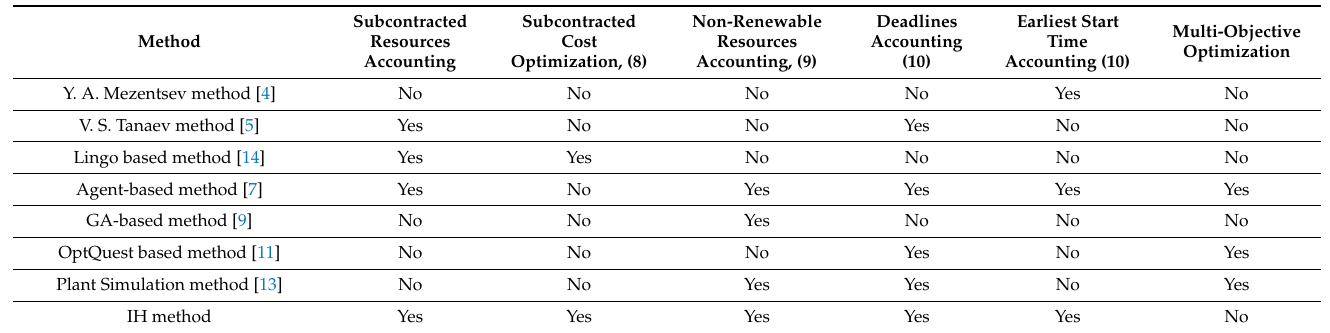
Table 8. The results of the scheduling method